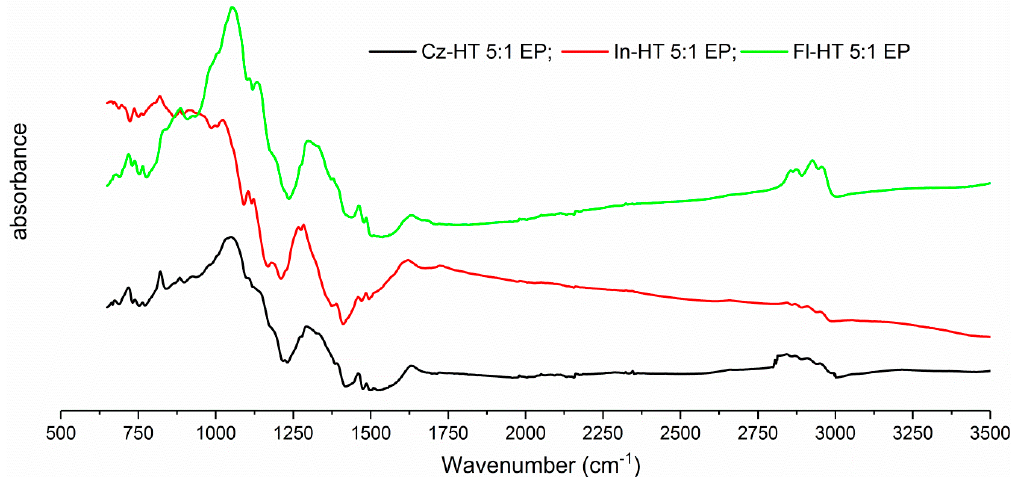
Figure A5. IR spectra of the polymer deposits obtained during electrochemical polymerisation of In-HT, Cz-HT and Fl-HT in the presence of 10 vol % boron trifluoride diethyl etherate.